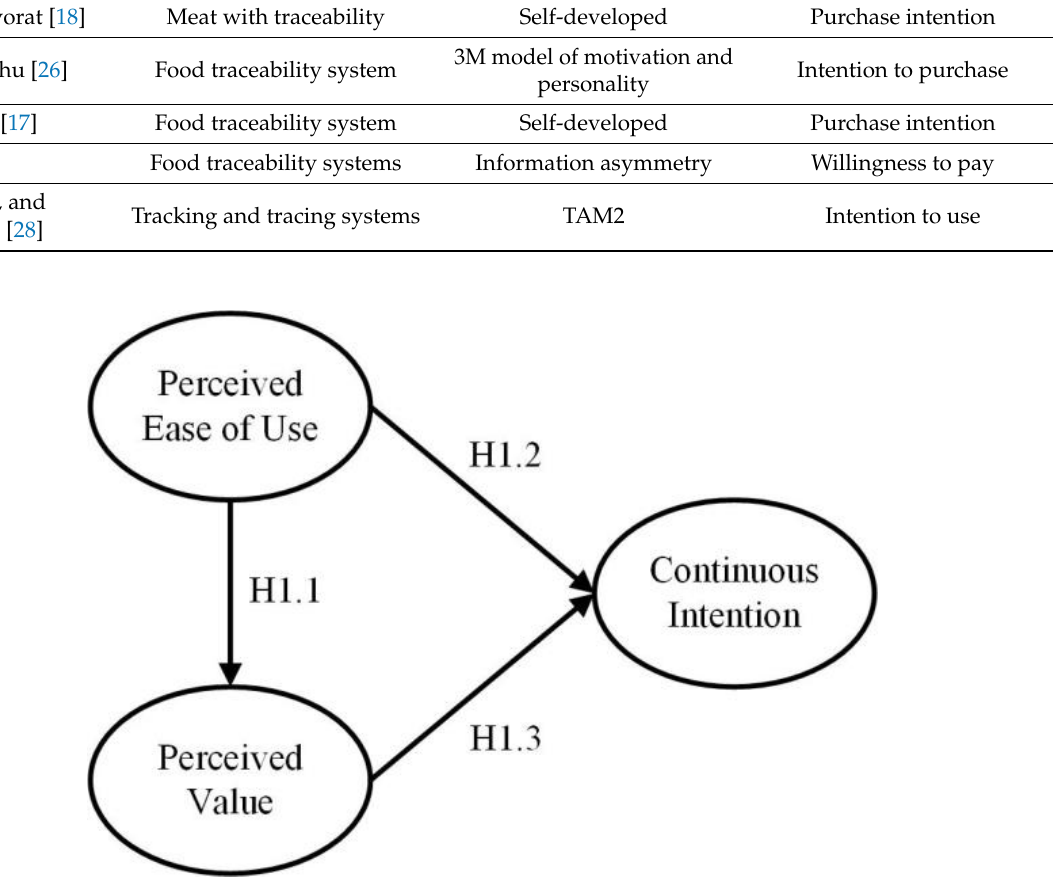
Figure 1. Research Model I (TAM).